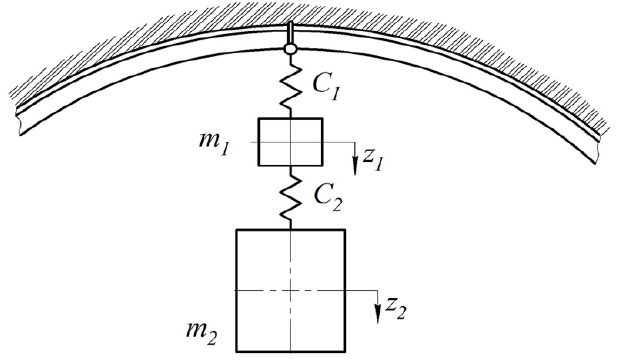
Figure 2. Calculation scheme of absorption of shock applied to the suspension.